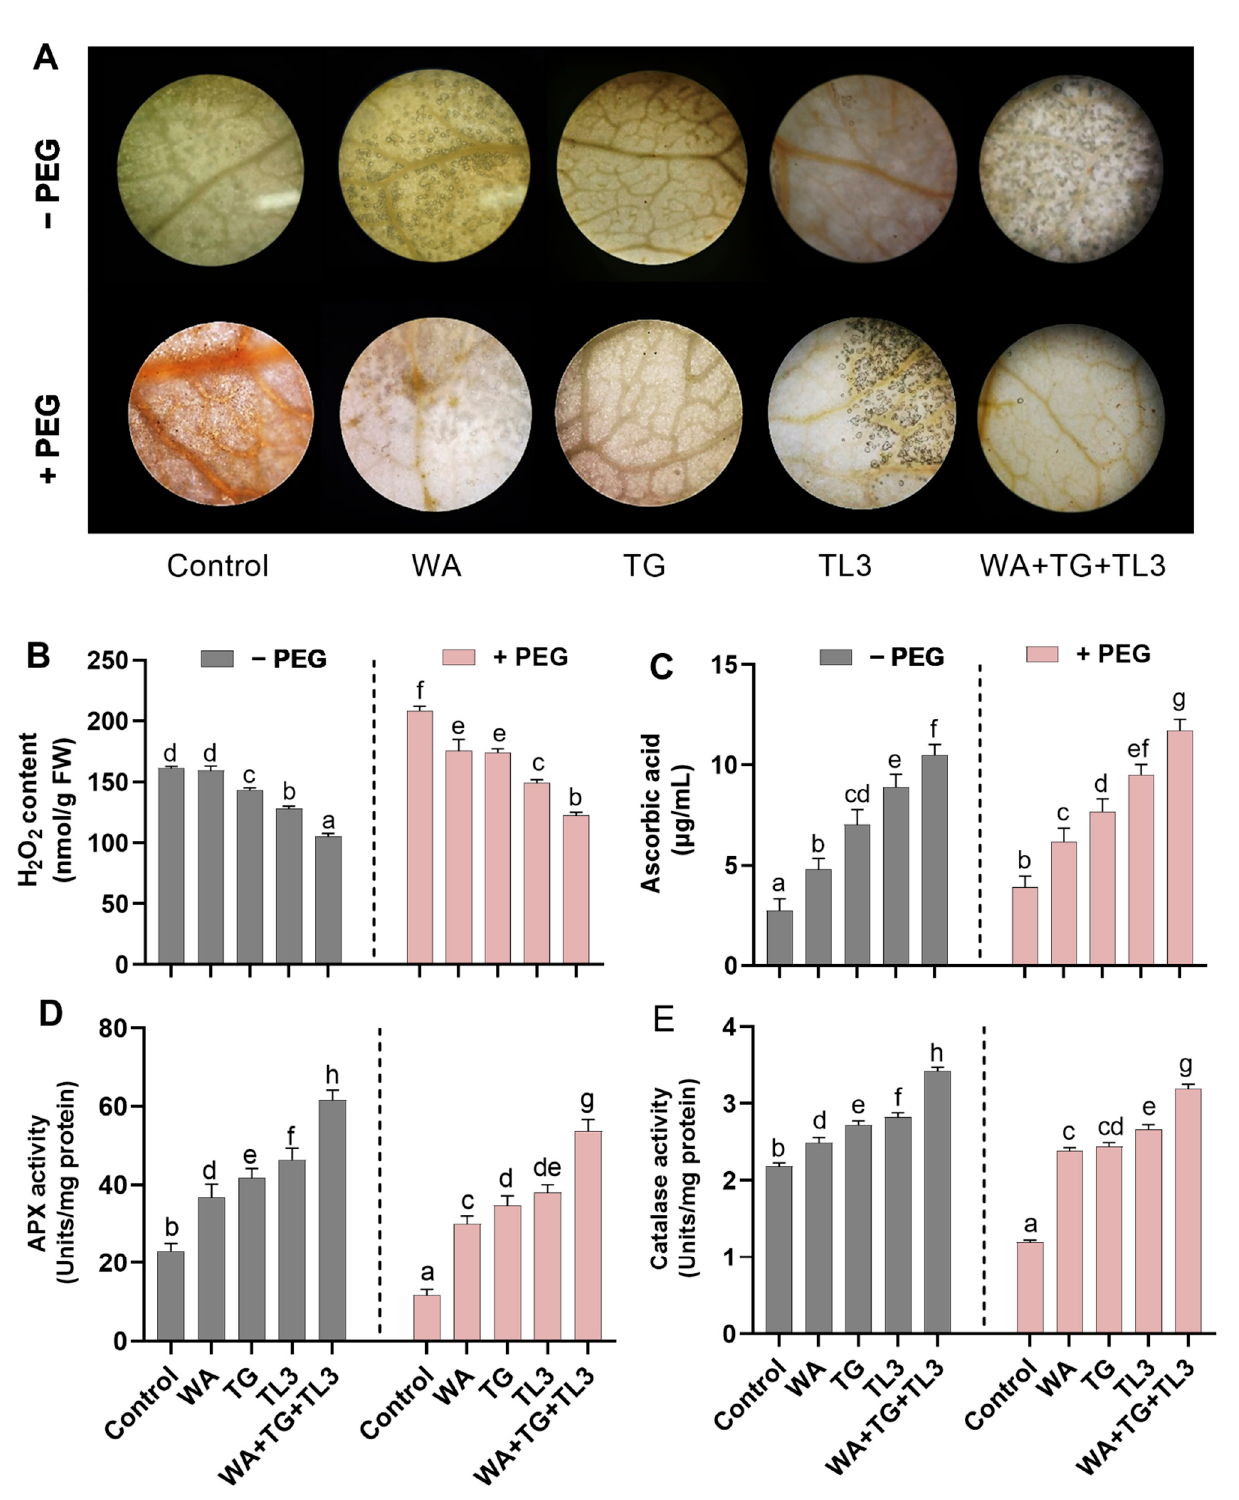
Figure 8. Effect of WA, TG, and TL3 inoculation on M. oleifera ROS production and antioxidant system. ( A ) DAB staining using leaf segment from 35-d-old plants, ( B ) H 2 O 2 level, ( C ) AsA, ( D ) ascorbate peroxidase activity, and ( E ) catalase activity. Quantitative data represent means ± SE of three independent biological replicates presented with various letters showing differences at a significance level of p ≤ 0.05 using Duncan’s multiple range test (DMRT).